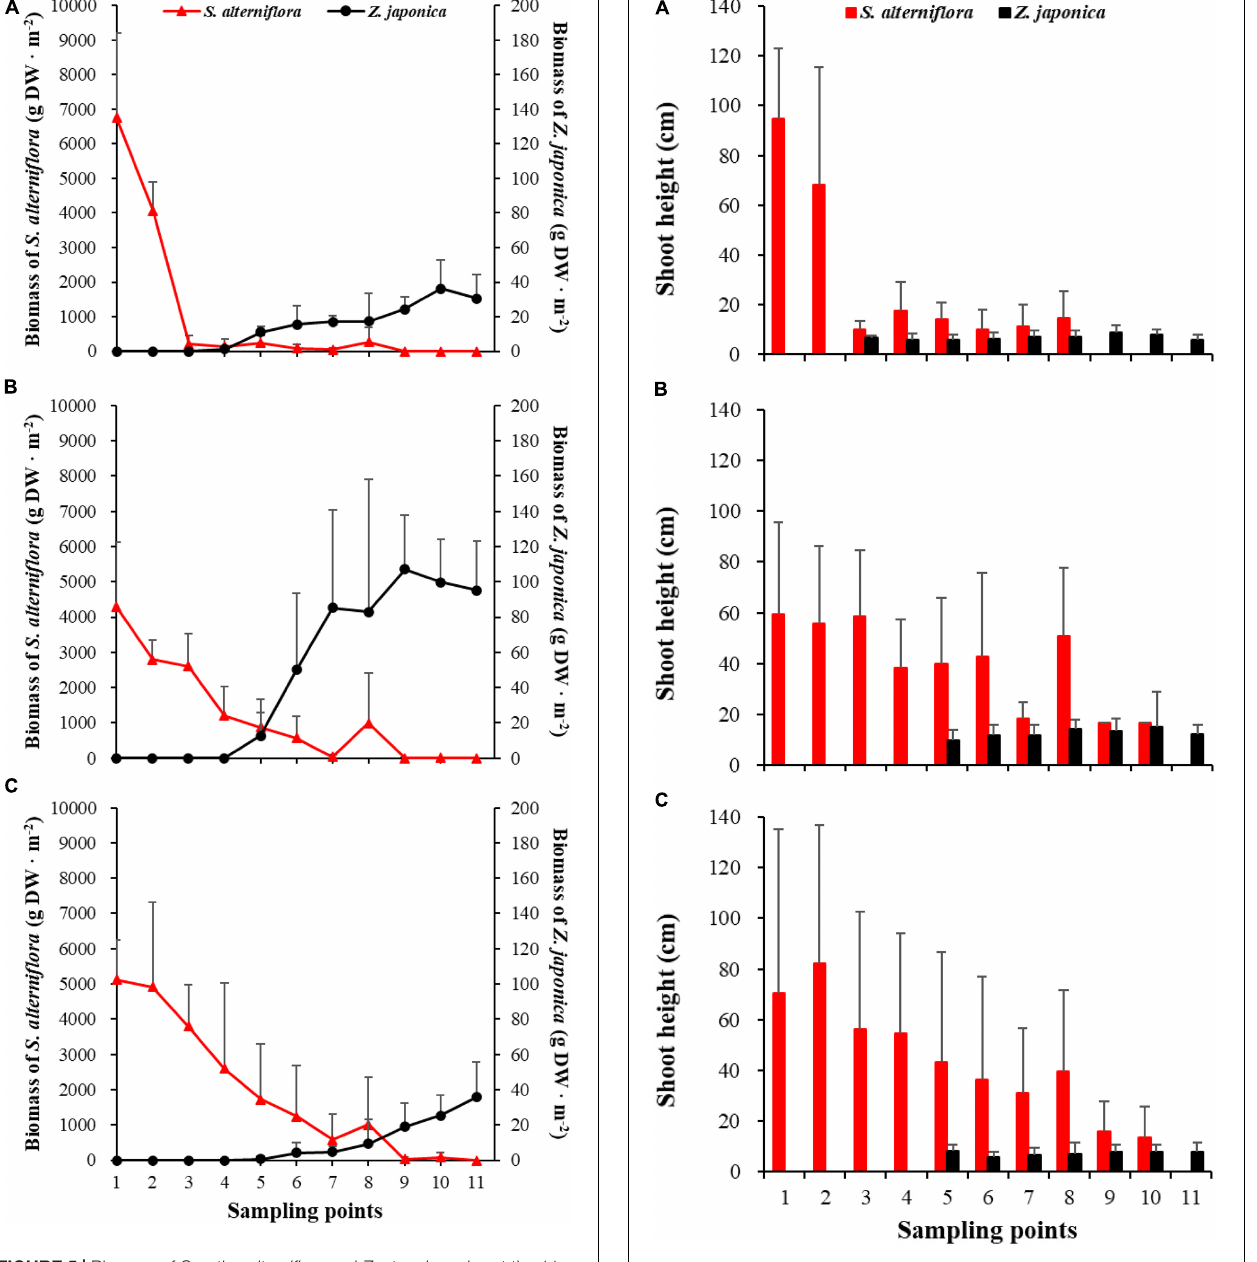
FIGURE 6 | Shoot height of Spartina alterniflora and Zostera japonica at the 11 sampling points in April (A) , July (B) , and October (C) 2019. Values are mean ±